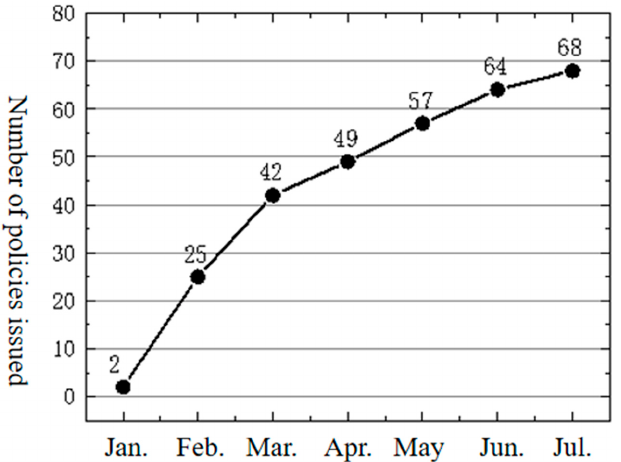
Figure 1. Trends in policy issuance.